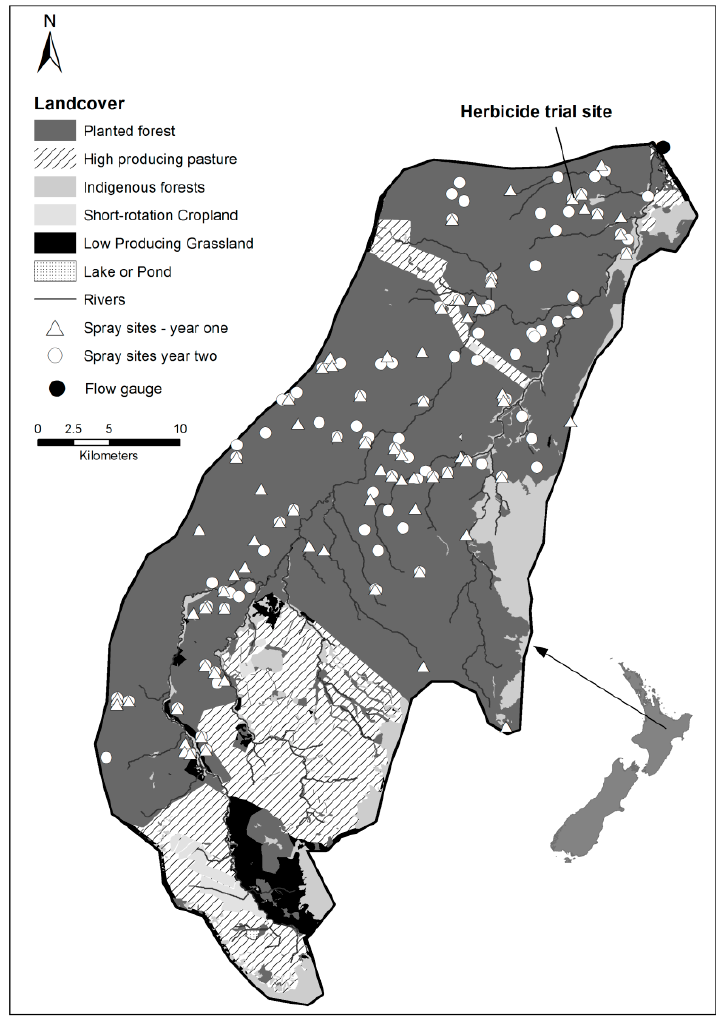
Figure 1. The upper Rangitaiki River catchment study area in the North Island of New Zealand showing the land cover and the sites treated with herbicides in Year 1 and Year 2.